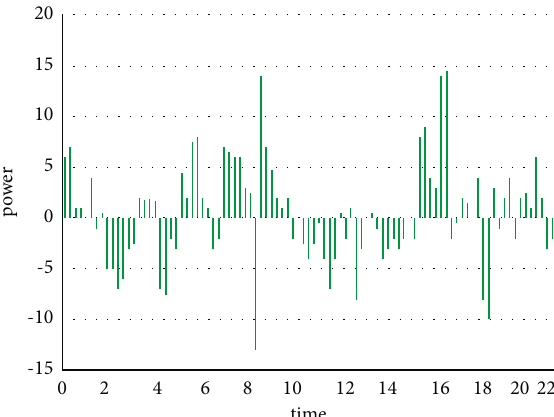
Figure 6: Action change diagram of energy storage system.